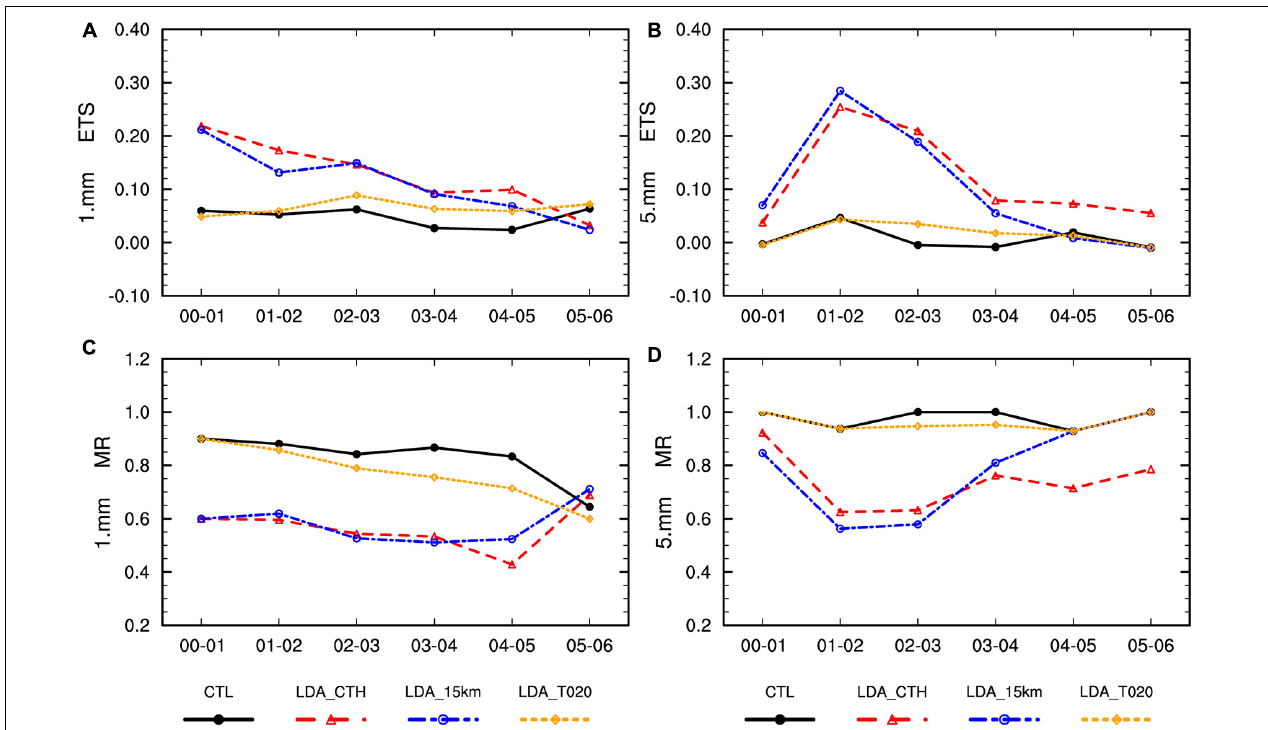
FIGURE 12 | The equitable threat score (ETS) (A,B) and missing rate (MR) (C,D) of the simulated hourly accumulated precipitation against the observations from 0000 UTC to 0600 UTC on 30 June. The thresholds for precipitation are 1 mm (A,C) and 5 mm (B,D)